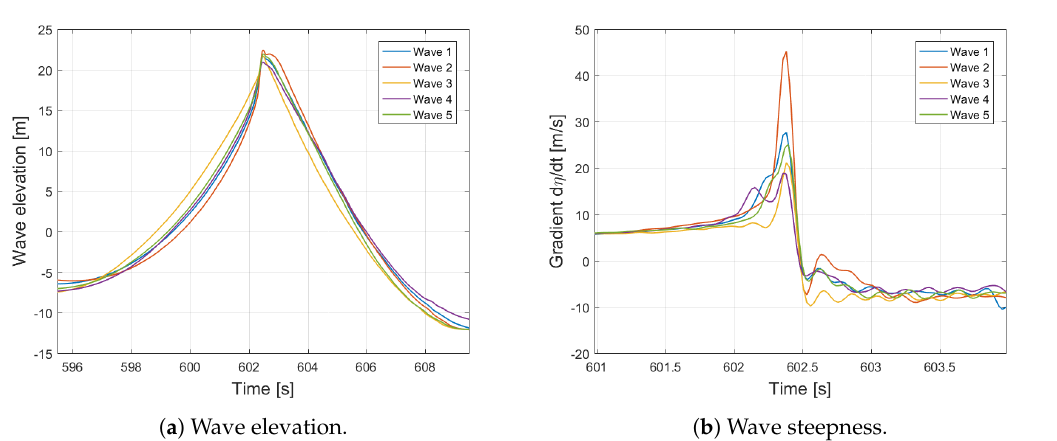
Figure 18. Five focused waves and their steepness calibrated for the BreaKin JIP. Figure based on the same data as a figure in [33].